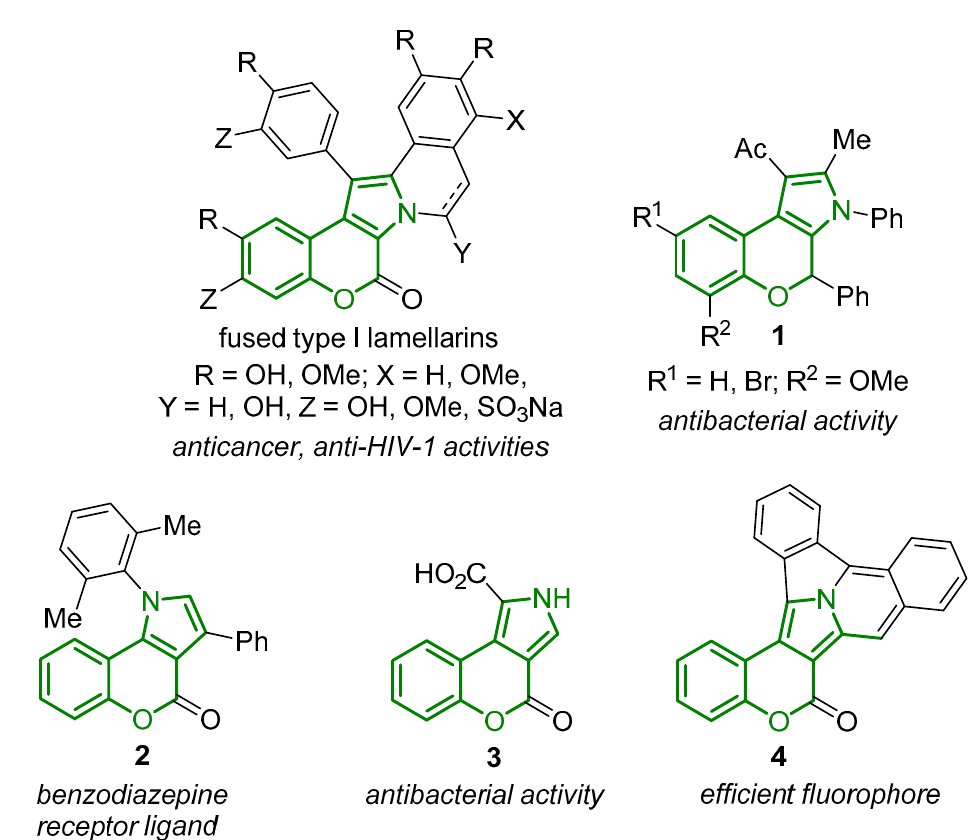
Figure 1. Representative natural and synthetic chromenopyrroles.